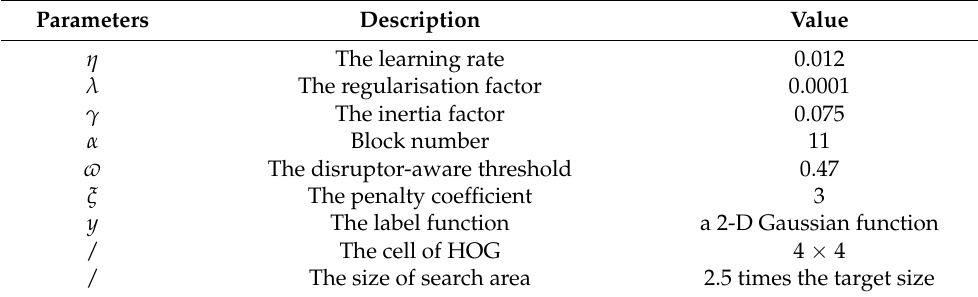
Table 1. Parameter